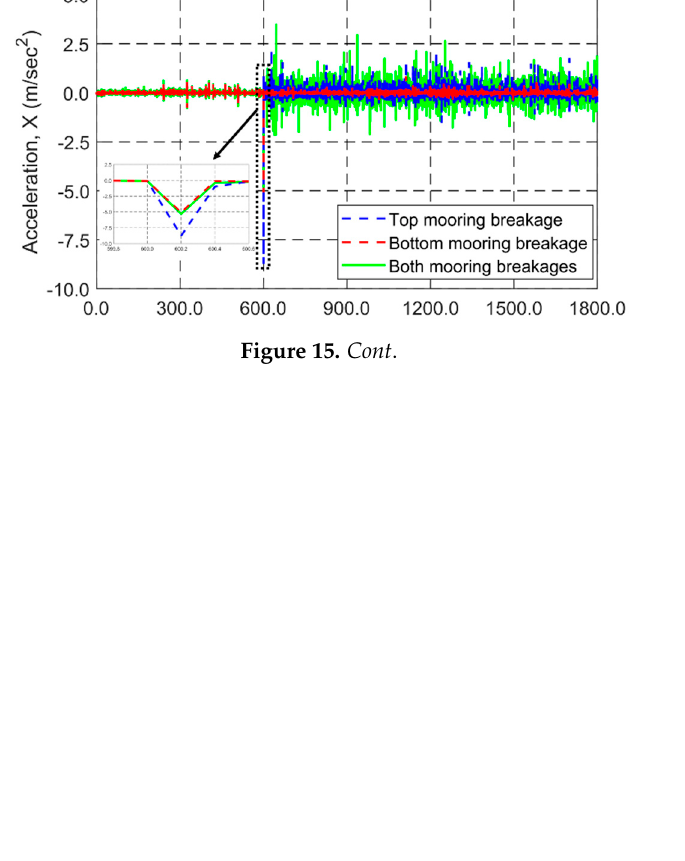
Figure 14. Time histories of the surge motion of the location buoy in the middle location (Y = 0 m) as mooring lines in the middle location (Y = 0 m) are broken after 600 s ( H s = 2.0 m, T p = 7.0 s, current velocity = 0.6 m/s).